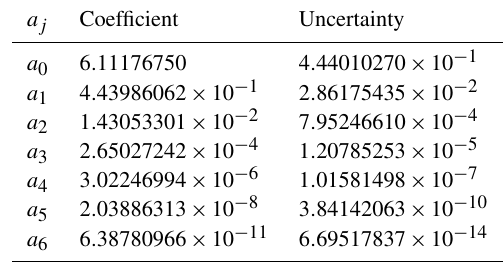
Table 1. Saturation vapour pressure coefficients and associated un- certainties (Flatau et al.,